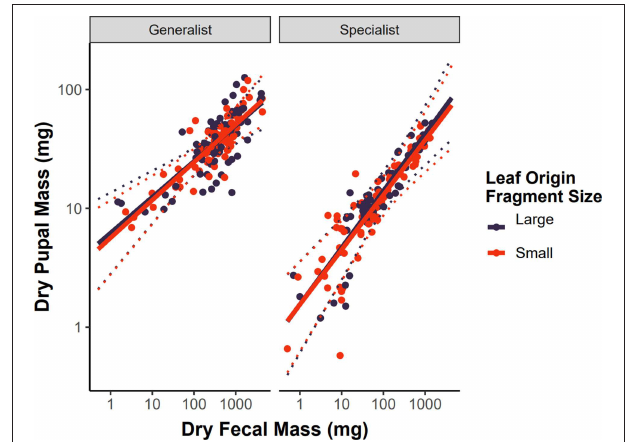
FIGURE 3 | Growth efficiency of dietary specialist and generalist subsets of the caterpillar community on leaves collected from small ( < 50 ha) or large ( > 200 ha) forest patches. We define growth efficiency as the relationship between dry fecal mass (a proxy for total food consumed) and dry pupal mass (finishing mass). Variation in the slope of these relationships would indicate variation in intraspecific hostplant quality. Solid lines represent the predicted values from LMMs, dashed lines represent 95% confidence intervals around the predictions, and points are the raw data reshaped to account for the random effects of caterpillar species.